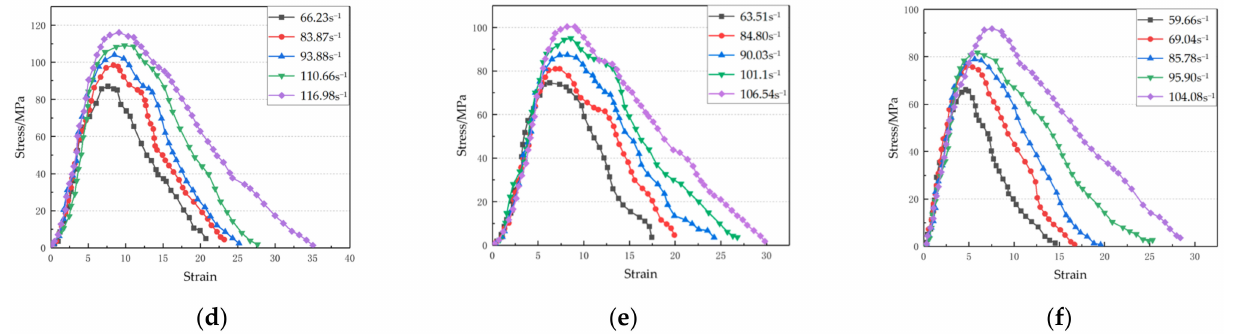
Figure 6. Stress-strain curves of each specimen ( a ) PCCY; ( b ) 1ACCY; ( c ) 2ACCY; ( d ) 3ACCY; ( e ) 4ACCY; ( f )